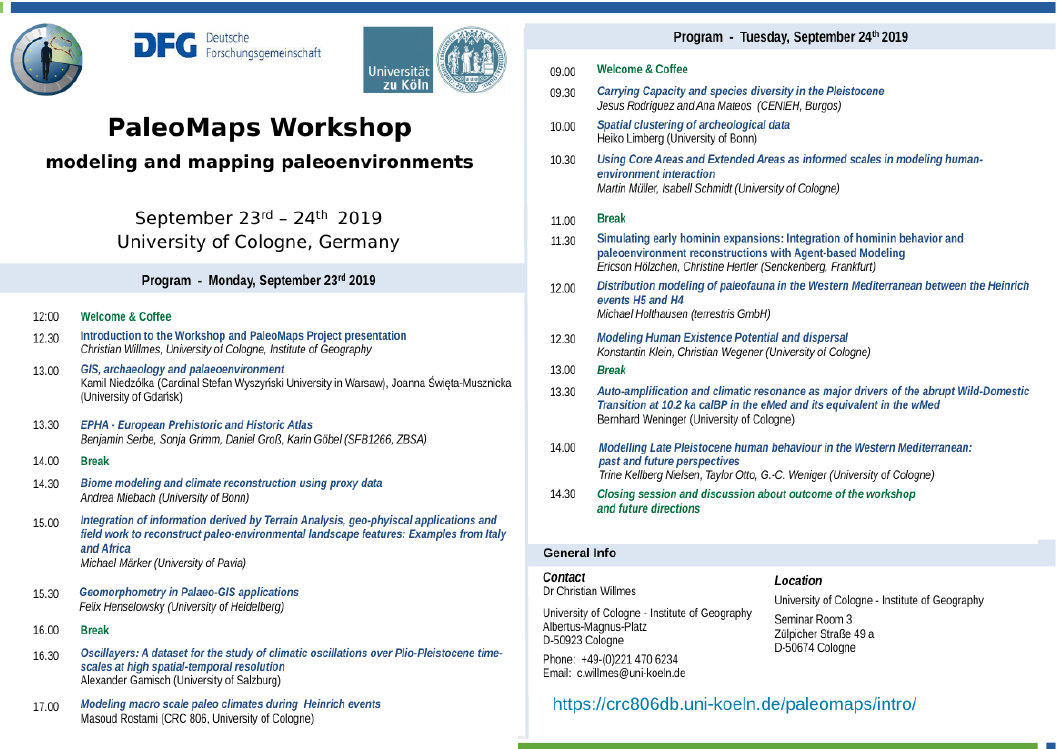
Figure 1. The program of the PaleoMaps Workshop, available online https://crc806db.uni-koeln.de/